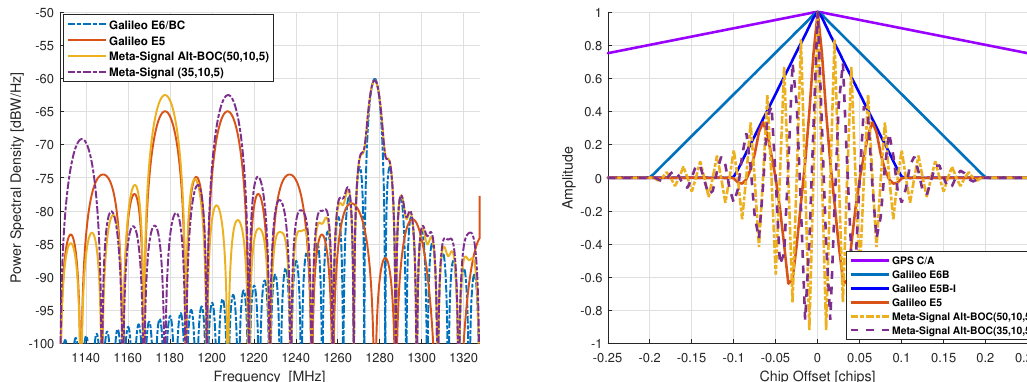
Figure 3. ( Left ) Galileo E5/E6 and GNSS meta-signal PSD, and ( Right) GPS L1 C/A, Galileo E6B, E5b-I, E5 and GNSS meta-signals ACFs, with intermodulation products . Notice the width of the E6B ACF